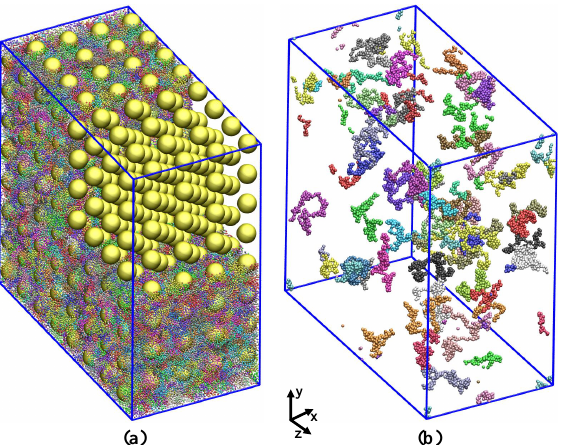
Figure 1. ( a ) Simulation snapshot of system L2 • , a fully relaxed undeformed IPNC system at NP volume fraction φ = 20.8%, dielectric constant ε r = 24, and monodisperse chains with N = 200 beads each. The small, colorful spheres depict the connected polymer beads, and the large golden ones stand for the NPs. Note that the surface of each NP is covered homogeneously with 720 smaller NP surface beads that are not shown here for the sake of clarity. Polymers in the top corner are removed so that the NP (almost perfect lattice) structure is visible. The system contains n = 2304 polymer chains, nN = 460800 polymer beads and 512 NPs in total (Table 1). ( b ) The same system in which only 50 randomly selected chains, each with a distinct color, is shown while the rest of the chains as well as the NPs are